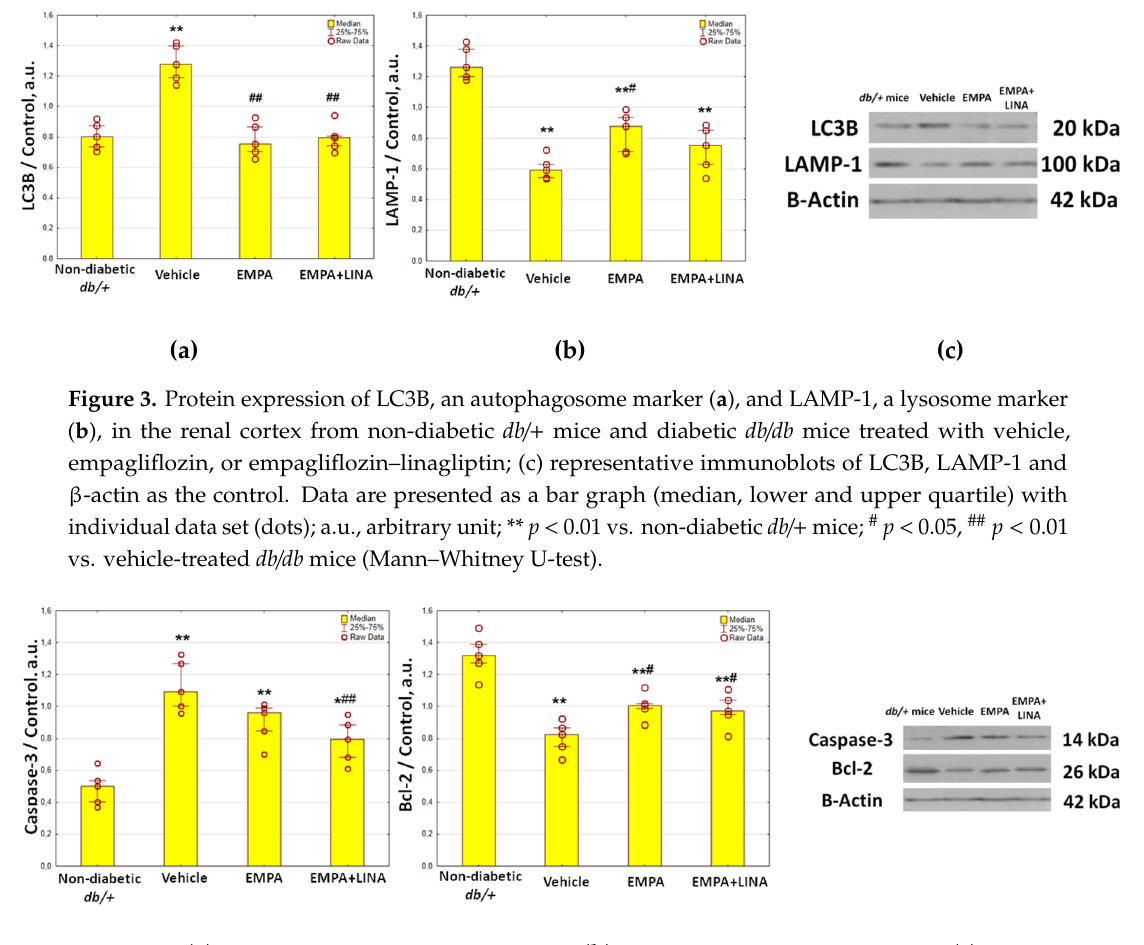
Figure 4. Protein expression of caspase-3, a regulator of apoptosis (a), and Bcl-2, an anti-apoptotic protein (b) in the renal cortex from non-diabetic db /+ mice and diabetic db / db mice treated with vehicle, empagliflozin, and empagliflozin–linagliptin; (c) representative immunoblots of caspase-3, Bcl-2 and β -actin as the control. Data are presented as a bar graph (median, lower and upper quartile) with individual data set (dots); a.u., arbitrary unit; * p < 0.05, ** p < 0.01 vs. non-diabetic db /+ mice; # p < 0.05, ## p < 0.01 vs. vehicle-treated db / db mice (Mann–Whitney U